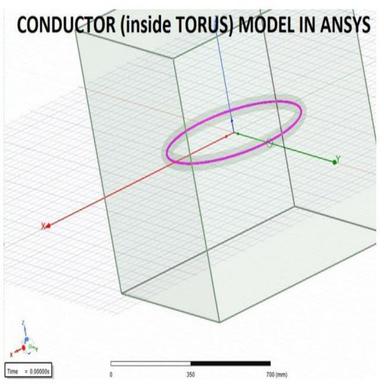
ANSYS Model of torus with current coil.